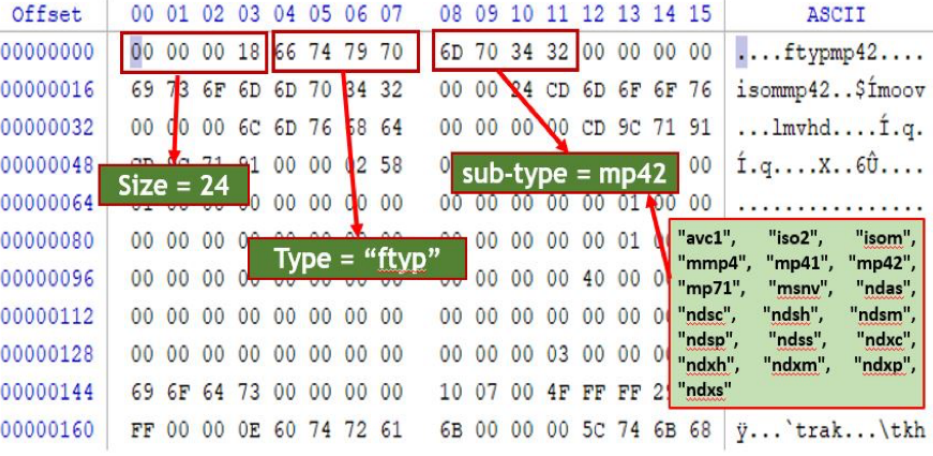
Figure 5. First chunk of a sample MP4 file.